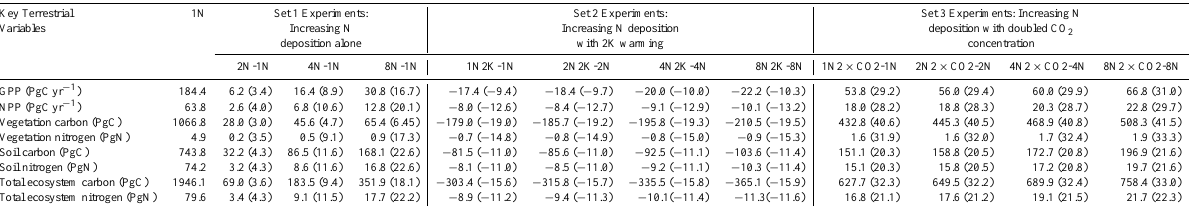
Fig. 2. CLM4 simulated global and annual mean changes in NPP, vegetation carbon, soil carbon and total ecosystem carbon for (i) N deposition, (ii) climate warming and (iii) CO 2 fertilization at various levels of N deposition. A 57yr running average is applied to original annual mean data. Table 1. Global mean changes in key ecosystem variables in the last 100yr of 1000yr simulations. Values in parentheses are %